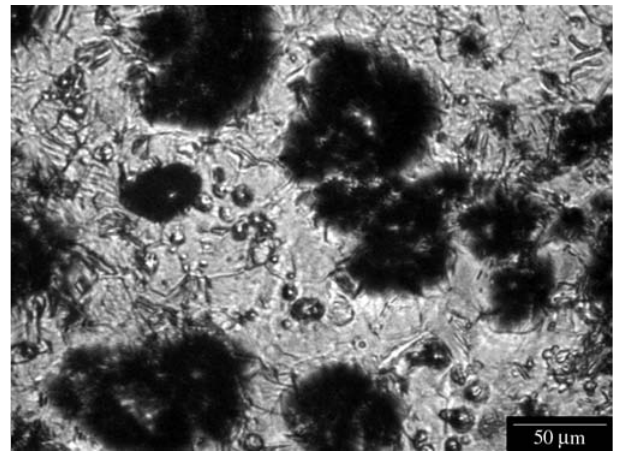
Figure 3. Microstructure of as-cast Mg + Ti